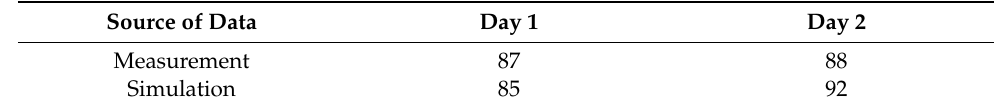
( b ) Figure 9. Power generation obtained by measurement and simulation: ( a ) first, ( b ) second day of analysis. Table 3. Energy produced by PV [Wh/m 2 ]. Source of Data